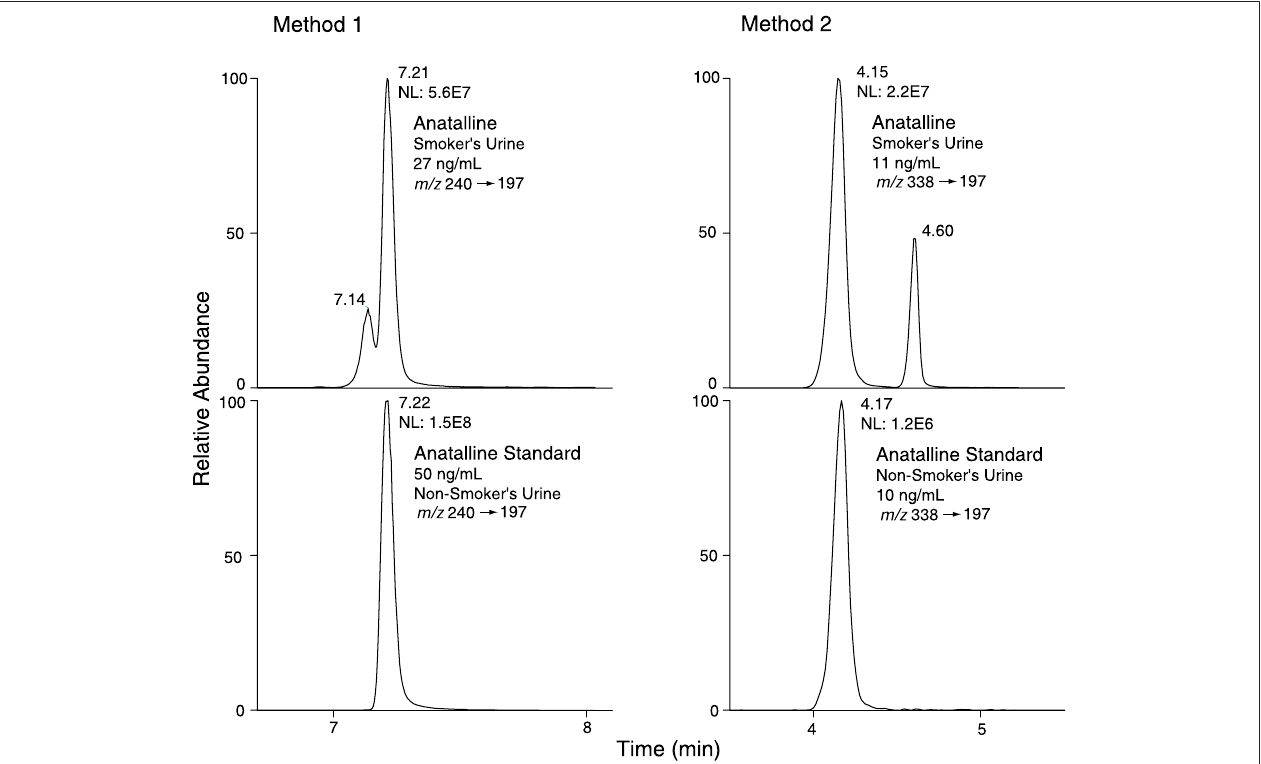
FIGURE7| Selectedreactionmonitoring(SRM)chromatogramsfromsmokers ’ urineandnon-smokers ’ urinespikedwithanatallinestandard,analyzedbyMethod 1 and 2. Detection of a possible isomer of anatalline.